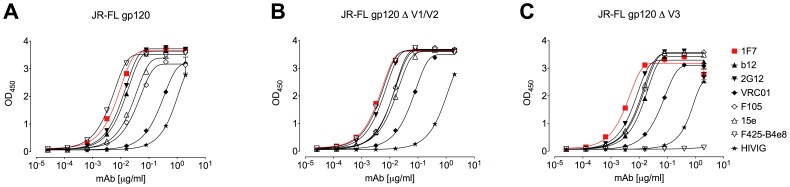
1F7 binding is independent of the gp120 variable loops V1/V2 and V3.Binding of 1F7 to recombinant gp120JR-FL and its truncation mutants in a direct ELISA shows that 1F7 binding is independent of V1, V2, and V3. (A) 1F7 binding to wild type gp120JR-FL, (B) the variable loop truncated variants gp120JR-FL ΔV1/V2, and (C) gp120JR-FL ΔV3. Antibodies b12, VRC01, F105, 15e, 2G12, and HIVIG served as positive controls for each gp120, and F425-b4e8 to V3 is a negative control for the ΔV3 construct. Each curve is representative of at least three independent experiments performed in duplicate.